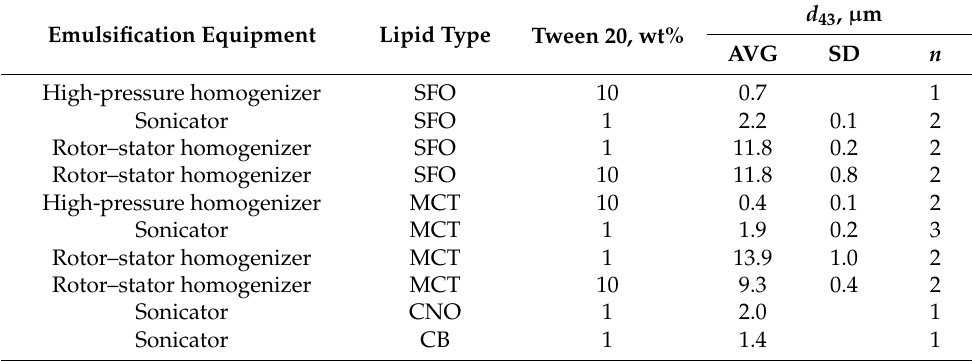
Table 2. Drop size of the prepared fenofibrate-loaded emulsions, presented as the volume-weighted mean diameter, d 43 . The number of emulsions prepared and used in the study is denoted as n ( n = 1 indicates that the same emulsion was used for all experiments in the